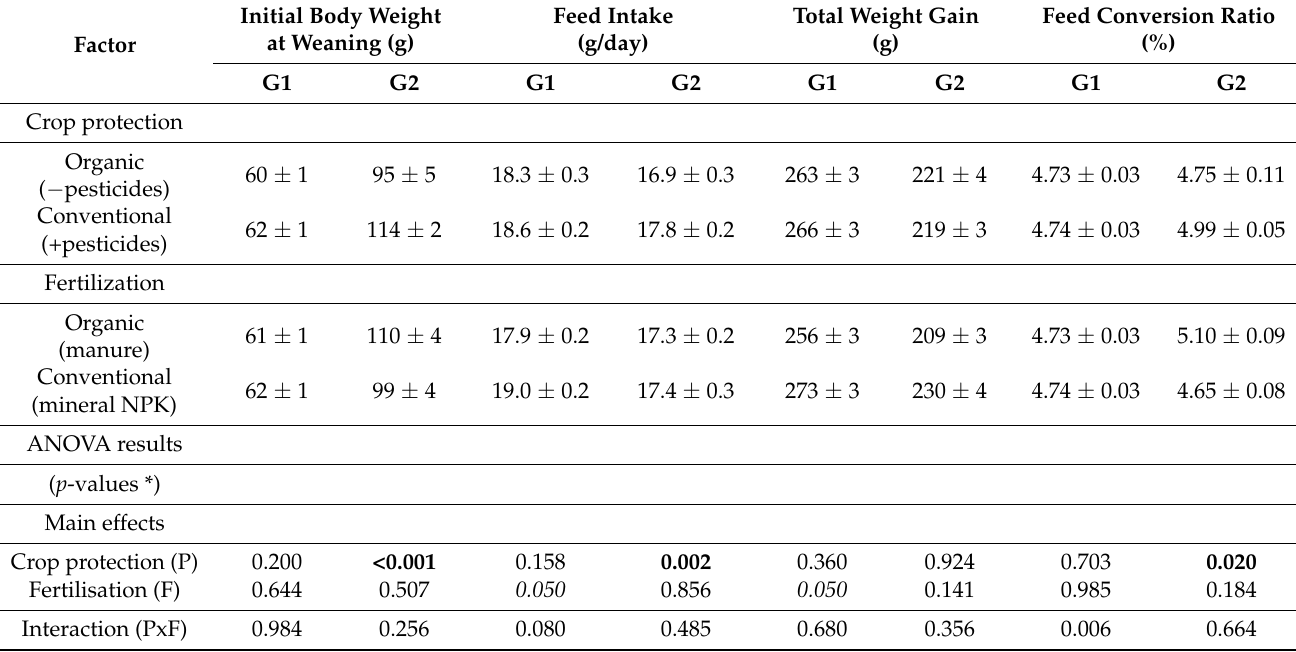
Table 1. Effect of crop protection and fertilization on the growth parameters of the first (G1) and second (G2) generation rats. Values shown are means ±